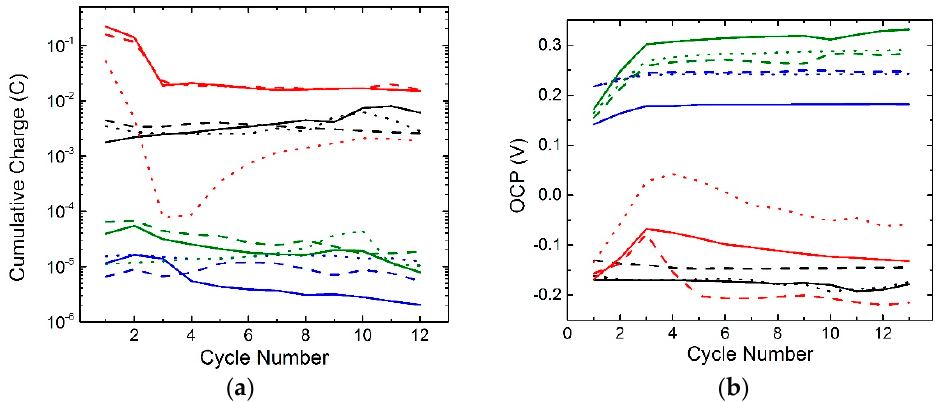
Figure 4. Cumulative charge plot ( a ) and OCP variation ( b ) during the electrochemical stress of 30 min repeated 12 times. Au +20 mV (black), Au +100 mV (red), Pd +20 mV (blue), Pd +100 mV (green); (1) samples (solid line), (2) samples (dash line), (3) samples (dot line).